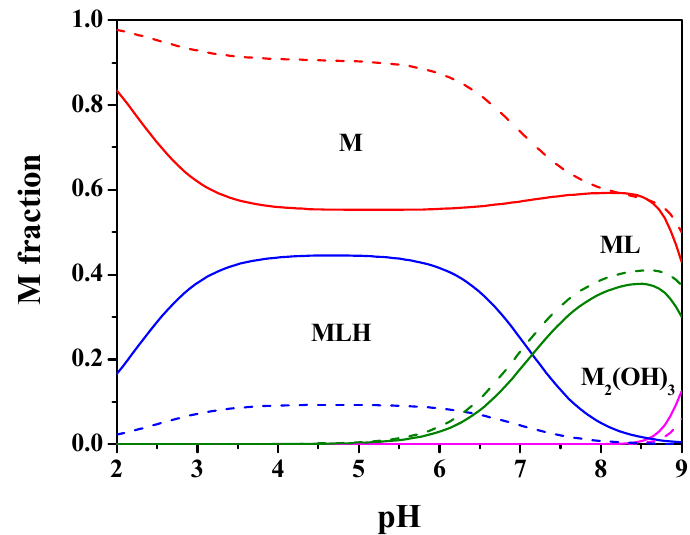
Figure 2. Speciation diagram of Mn 2+ - Amp (L) system, at C M = 2 mmol L − 1 , C L = 4 mmol L − 1 , t = 25 °C, I = 0.15 mol L − 1 (solid line), I = 1 mol L − 1 (dashed line).